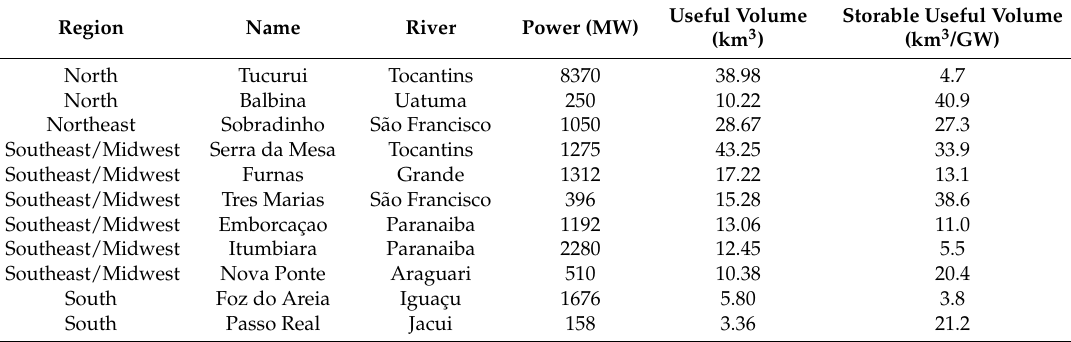
Table 1. Main Brazilian hydropower plants with reservoirs—based on data from [24]. Region Name River Power (MW)